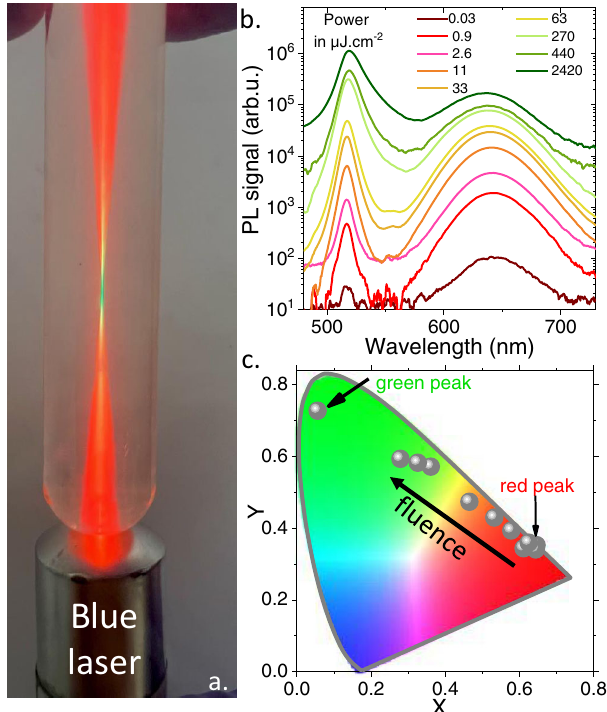
Fig. 3 | Power-dependent luminescent properties. a Image of a test tube con- taining a dilute solution of CdSe/CdTe/CdSe core/crown/crown NPLs, illuminated by a blue 405nm laser diode. the bottom of the tube acts as a lens and lumines- cenceatthefocalpointisgreenwhilebeingredawayfromit. b Photoluminescence spectra of CdSe/CdTe/CdSe core/crown/crown NPLs under various incident pow- ers. c Chromaticity diagram and position of the PL signal resulting from the CdSe/ CdTe/CdSe core/crown/crown NPLs as the incident power is